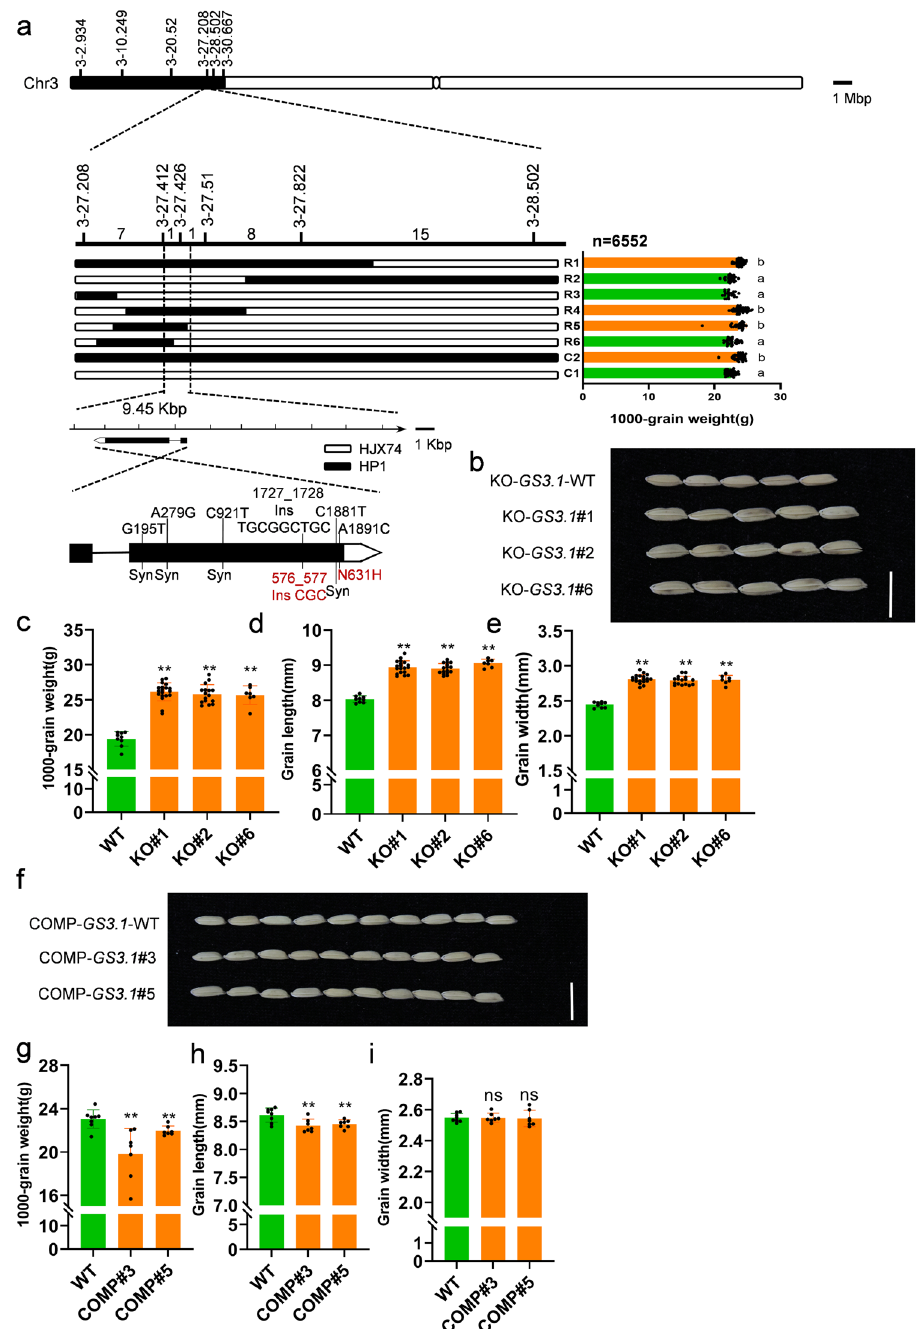
Fig. 1 Map-based Cloning of GS3.1 . a GS3.1 was preliminarily mapped to the interval between the markers 3-27.208 and 3-28.502 on the short arm of chromosome 3 and then narrowed to a 9.45 kbp region containing one gene. The numbers of recombinant individuals are shown between the marker positions. 1000-grain weight is shown on the right of each representative recombinant line. Recombinant lines R1 to R6 originated from recombinant line C2. Values represent the mean ± s.d. ( n ≥ 23 plants). Different letters indicate signi fi cant differences ( P < 0.05) as determined by a Tukey ’ s test. Single nucleotide mutations and the corresponding amino acid changes in NIL- GS3.1 HP are shown on the schematic illustration of the GS3.1 gene. Syn, synonymous variations. b Mature grains of GS3.1 knock out lines KO- GS3.1 #1, KO- GS3.1 #2, KO- GS3.1 #6, and the wild-type control. Scale bar = 1 cm. Comparison of 1000-grain weight ( c ), grain length ( d ), and grain width ( e ) between GS3.1 knock out lines and the wild-type control ( n ≥ 7 plants). f Mature grains of GS3.1 complementation lines COMP- GS3.1 #3, COMP- GS3.1 #5, and NIL- GS3.1 HP wild-type control. Scale bar = 1 cm. Comparison of 1000-grain weight ( g ), grain length ( h ), and grain width ( i ) between GS3.1 complementation lines and NIL- GS3.1 HP wild-type control ( n ≥ 7 plants). The values in c – e and g – i represent the mean ± s.d.. * P < 0.05 and ** P < 0.01 indicate signi fi cant differences compared to the control in two-tailed Student ’ s t -tests. The source data underlying Fig. 1a, c – e and g – i are provided as Source data fi le.